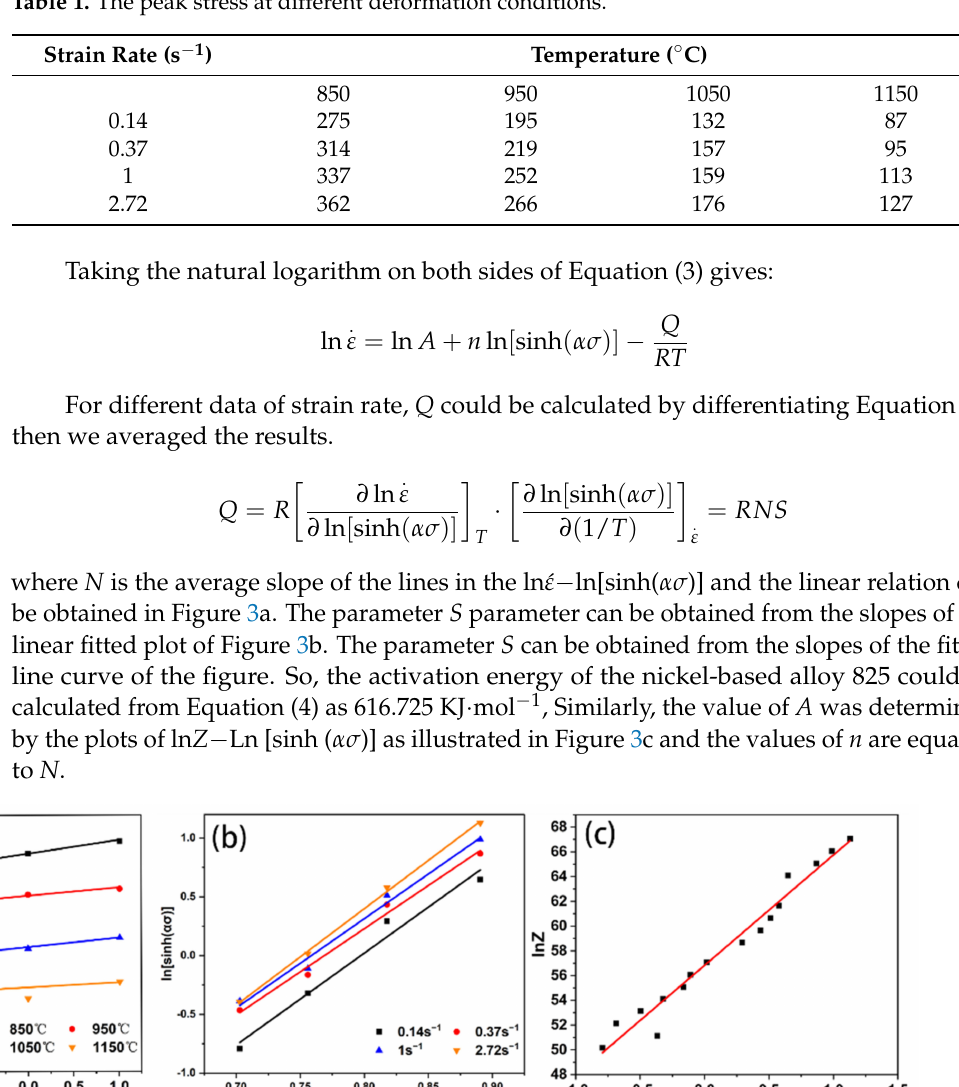
Table 1. The peak stress at different deformation conditions.